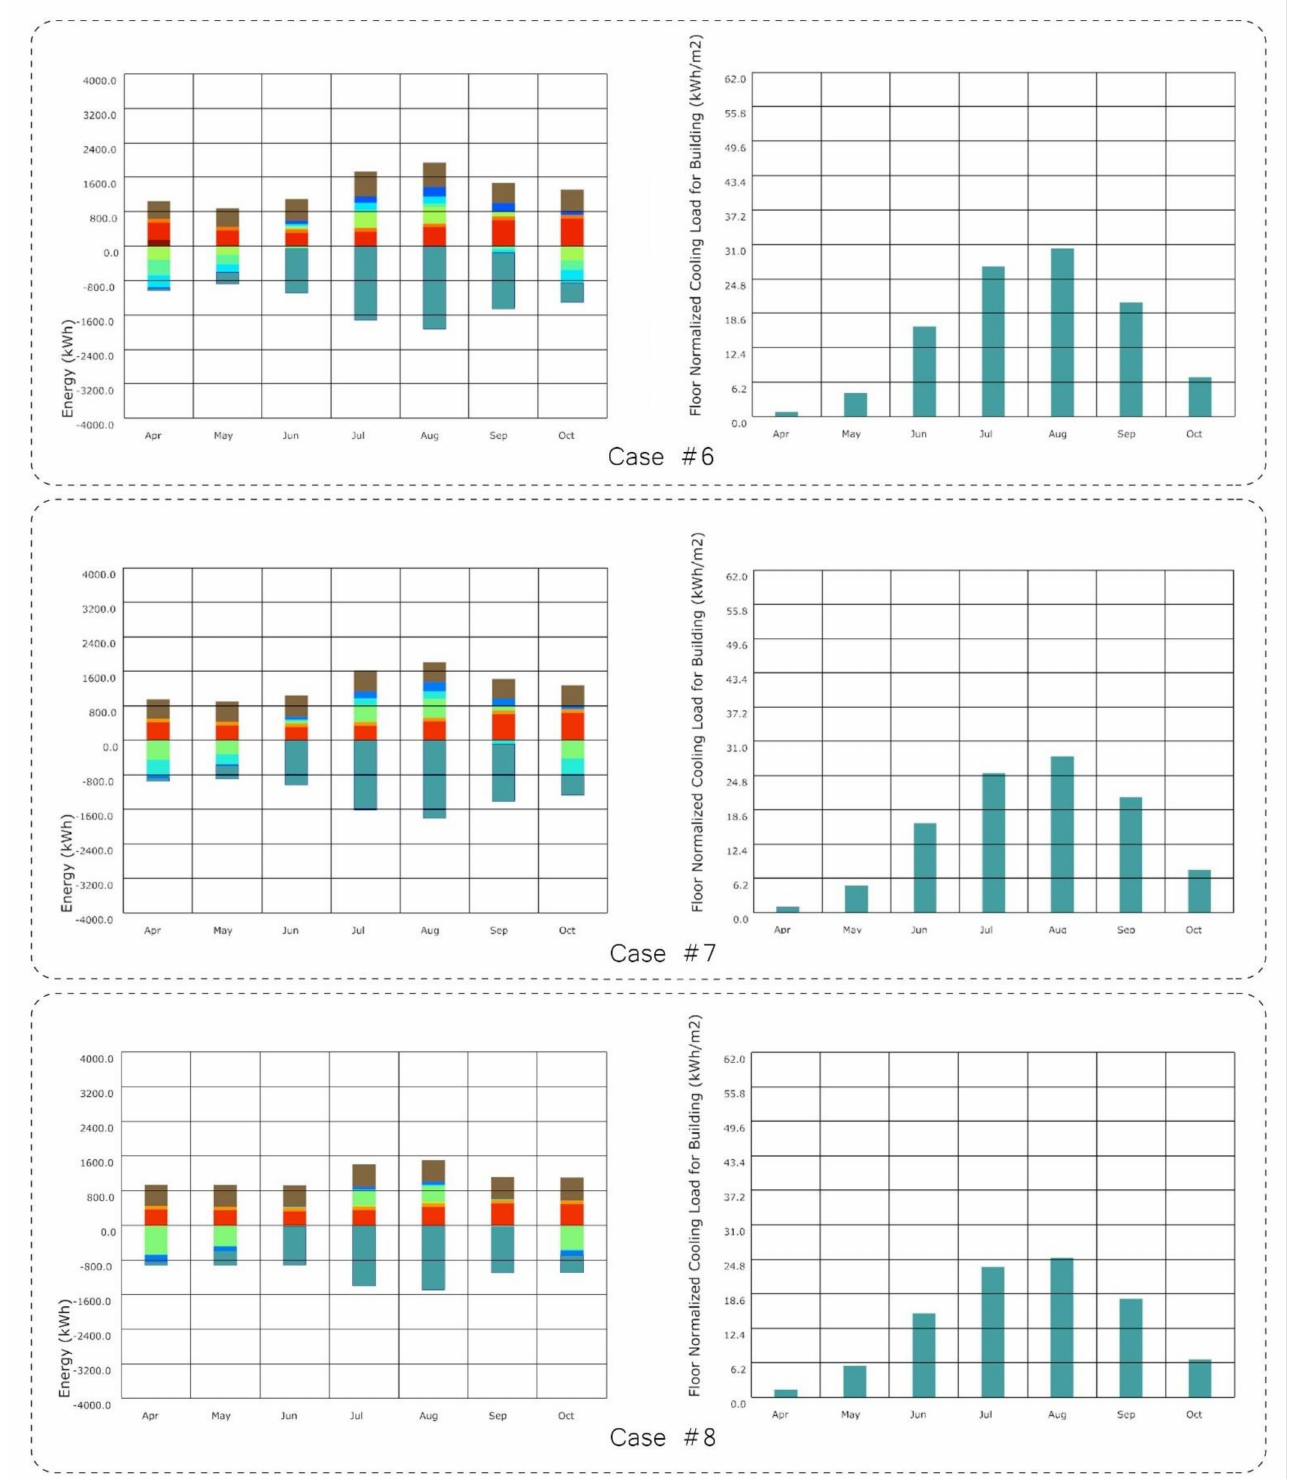
Figure 22. Energy balance charts ( left ) and EUI of the cooling loads charts ( right ) for each case study shown in Figure